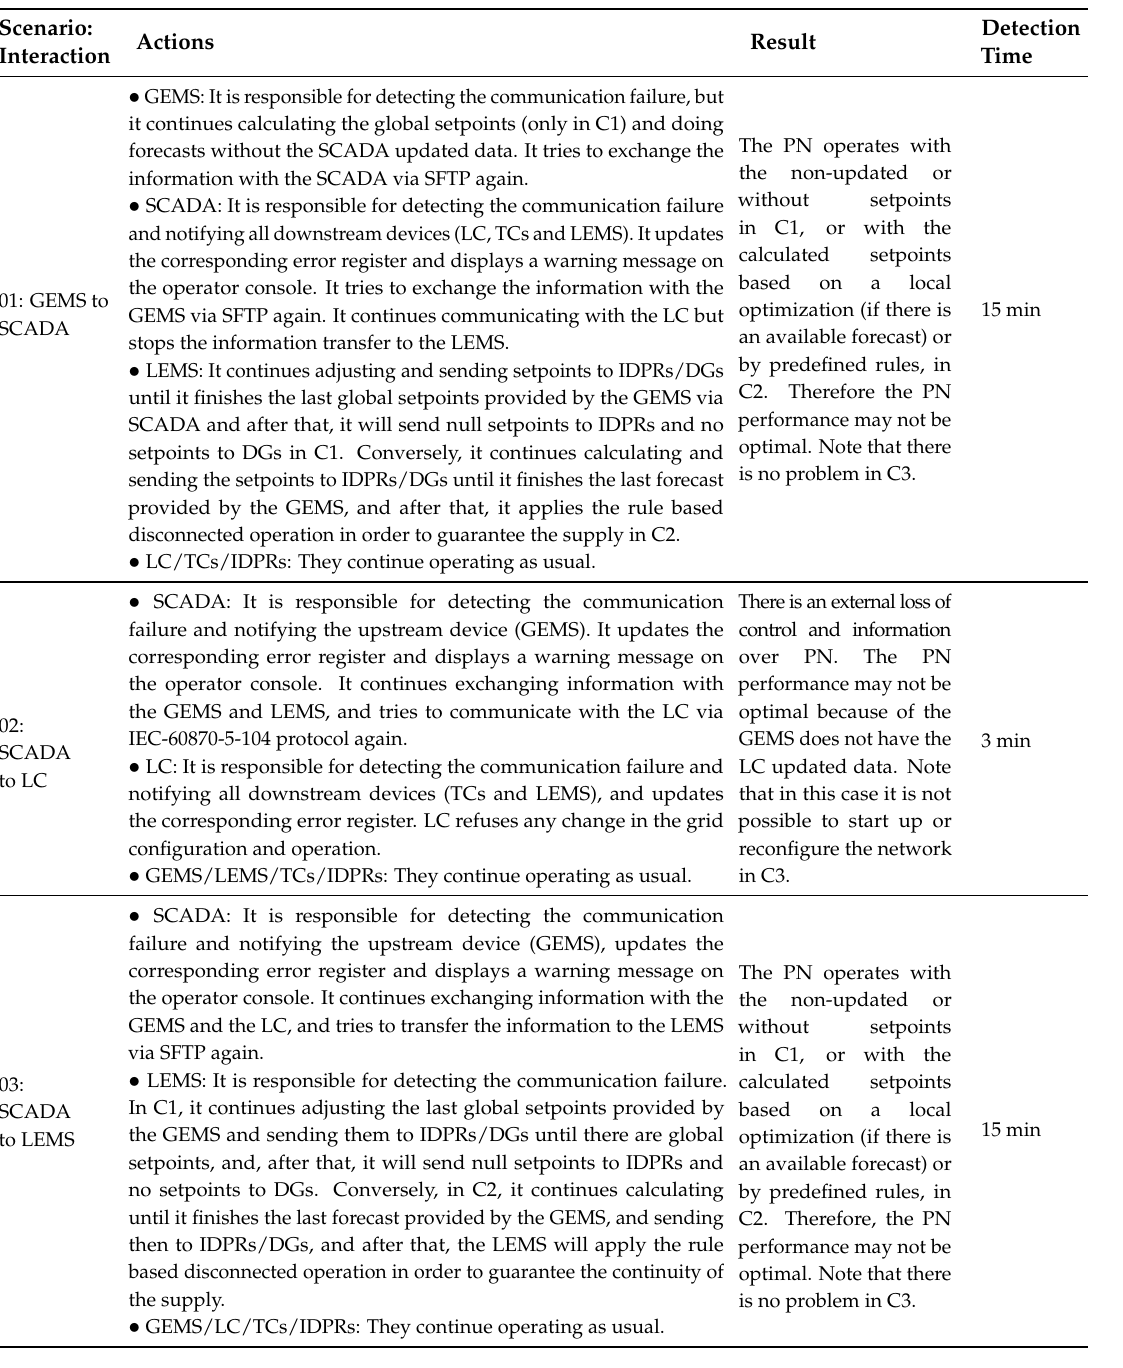
Table 5. Actions in function of the operational circumstances 1, 2, and 3. Part